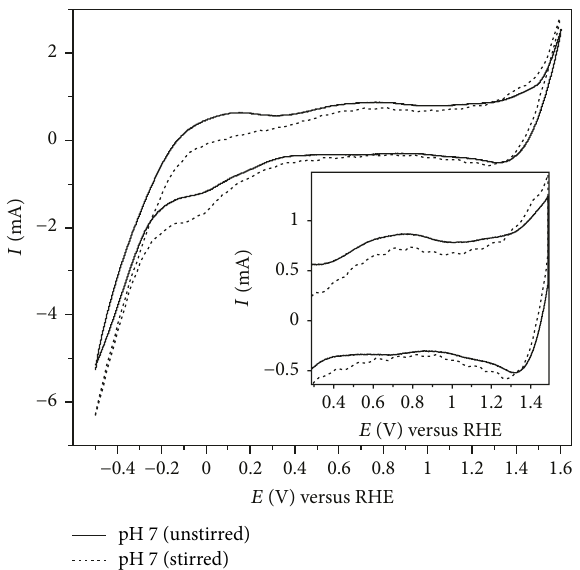
Figure 7: Hydrogen adsorption at a Ti/RuO 2 electrode in a stirred (300 min −1 ) and unstirred pH 7 buffer solution. CE: platinum